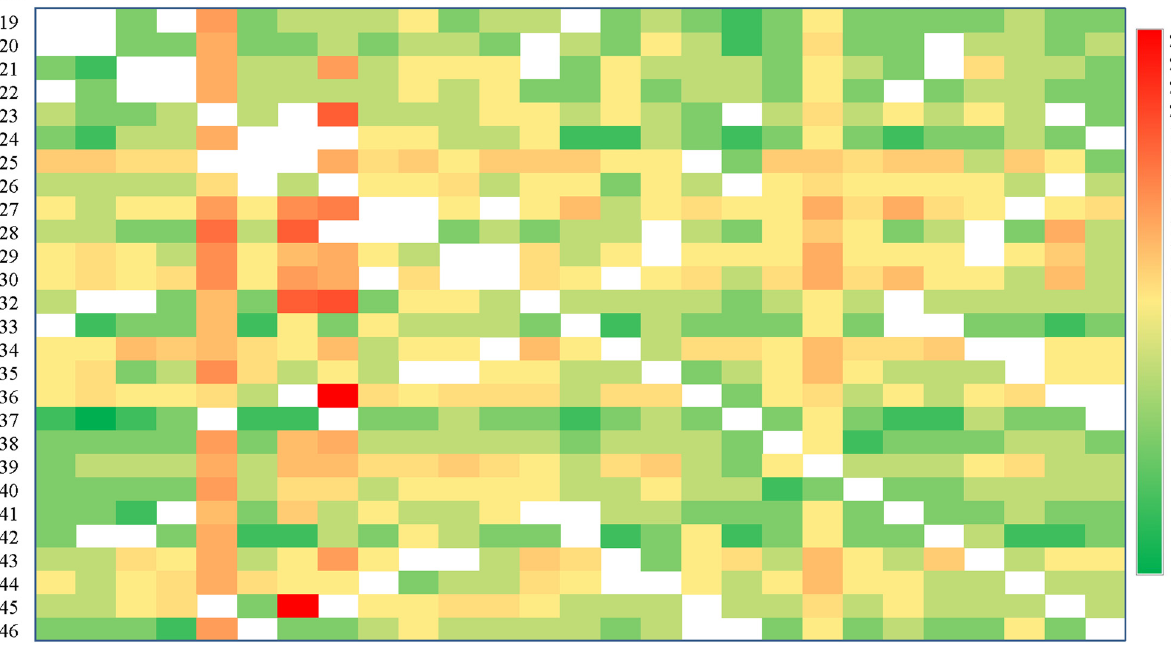
Figure 7: The posterior residuals of ISLs ’ pseudo - range after POD.